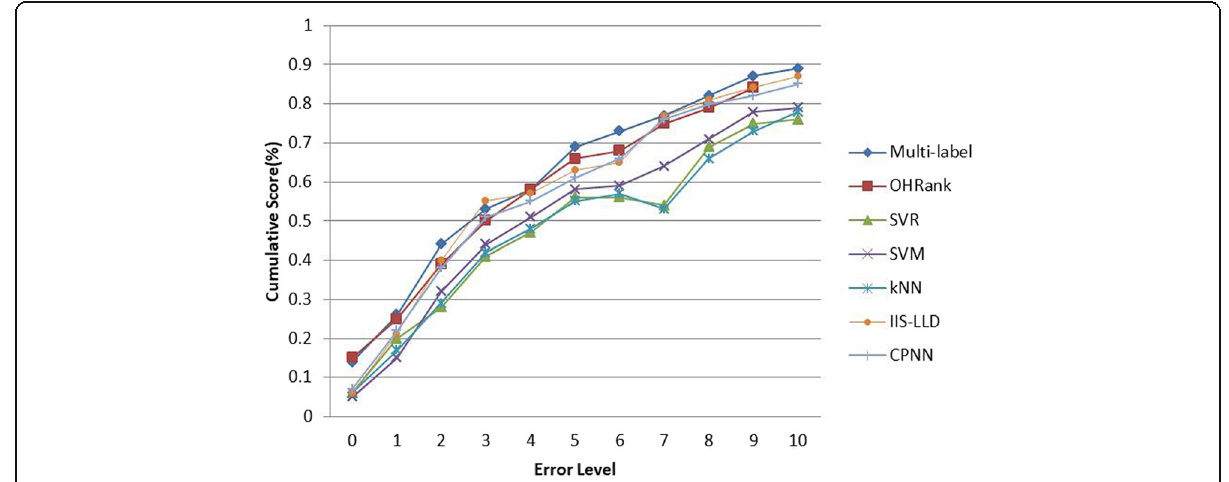
Fig. 2 CS curves with different error levels on the FG-NET